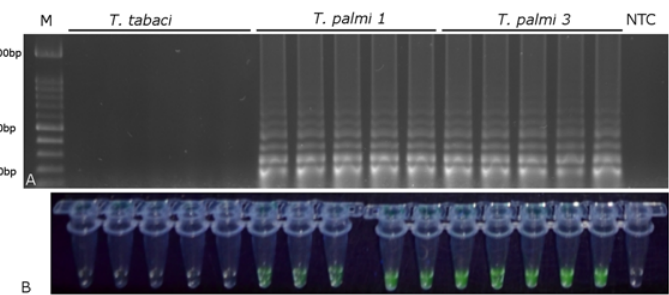
Fig 7. Visualization of LAMP reaction results without DNA extraction. A) After electrophoresis in a 1% agarose gel; B) using EvaGreen stain (Biotium). T.p. — T . palmi , T.t. — T . tabaci . NTC — no template control.